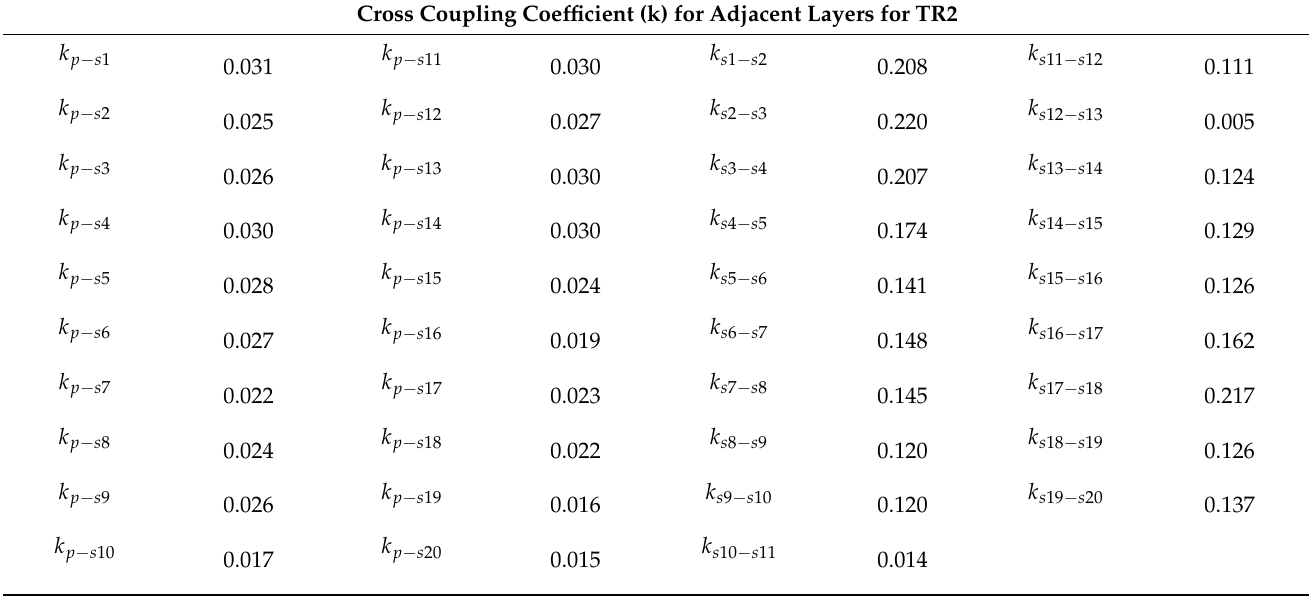
Table A2. Cross Coupling Coefficient for adjacent layers